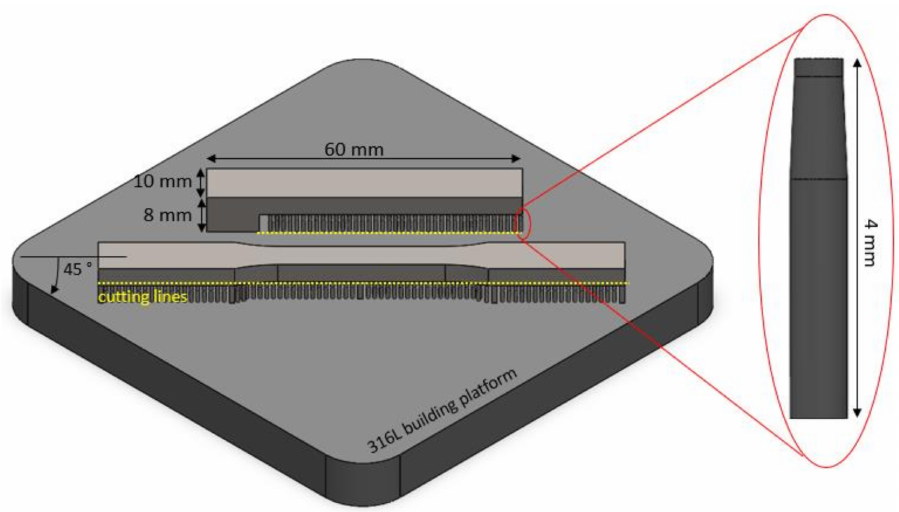
Figure 2. Specimen position on the building platform, geometry of support structures, and cutting lines